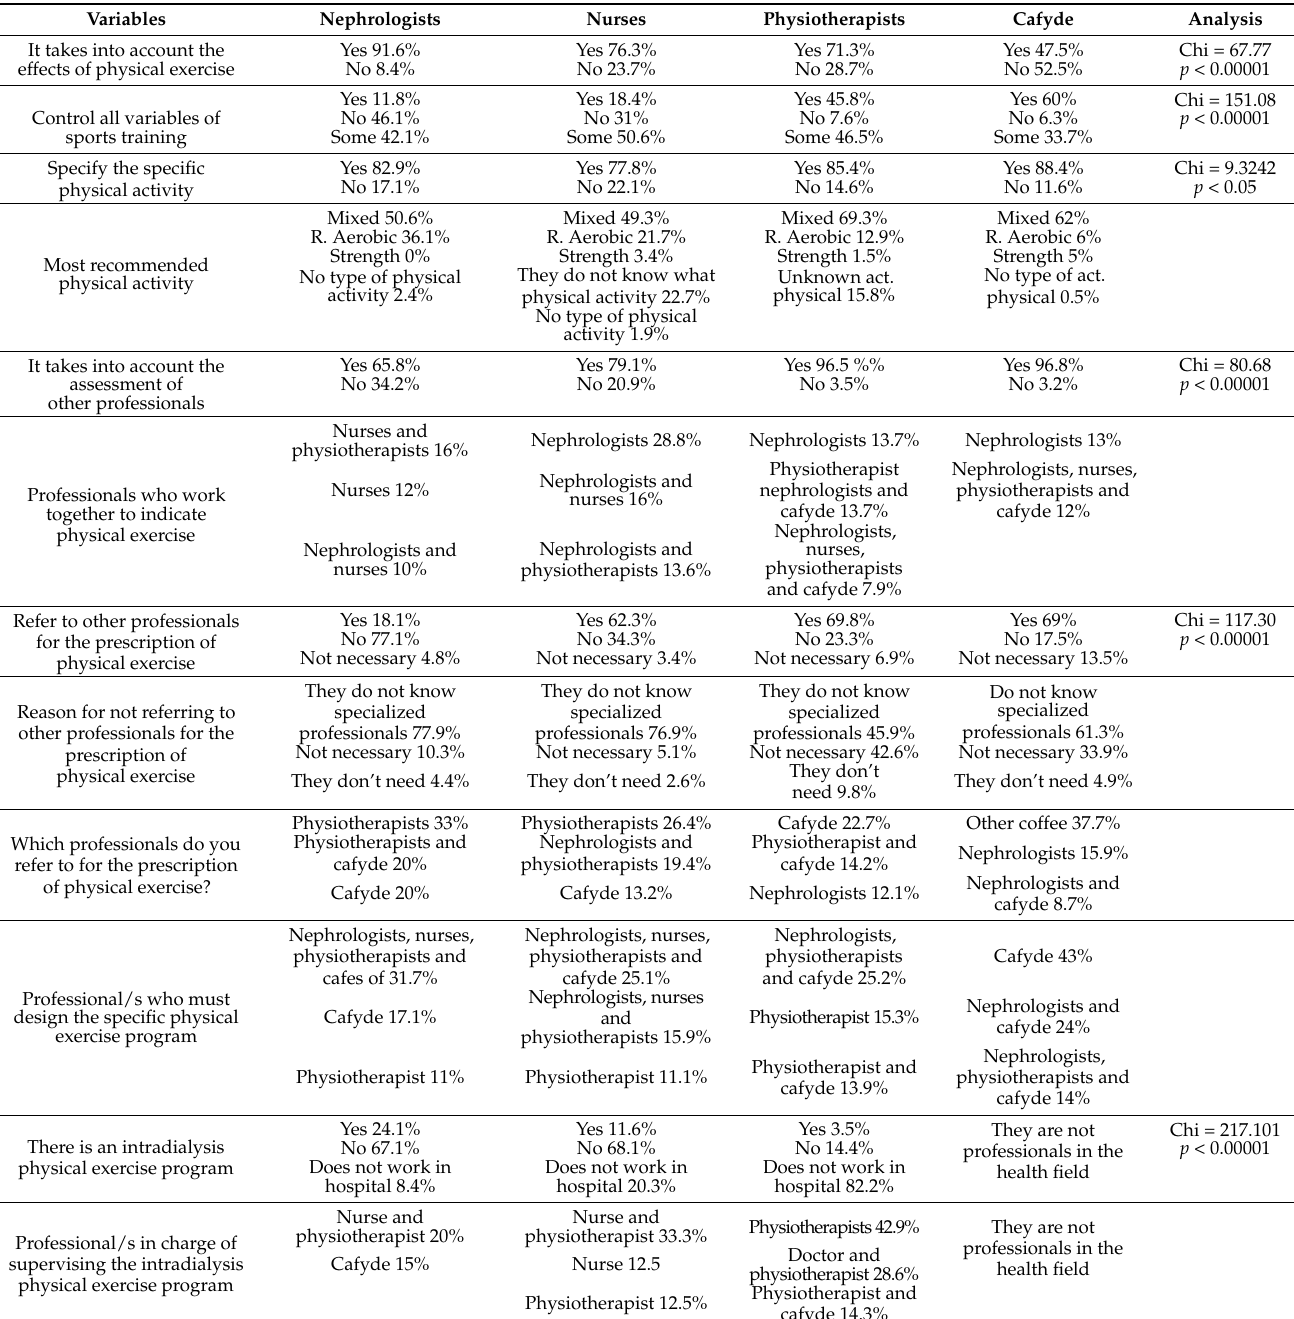
Table 2. Descriptive values and Chi-square test results for qualitative variables on physical exercise in CKD